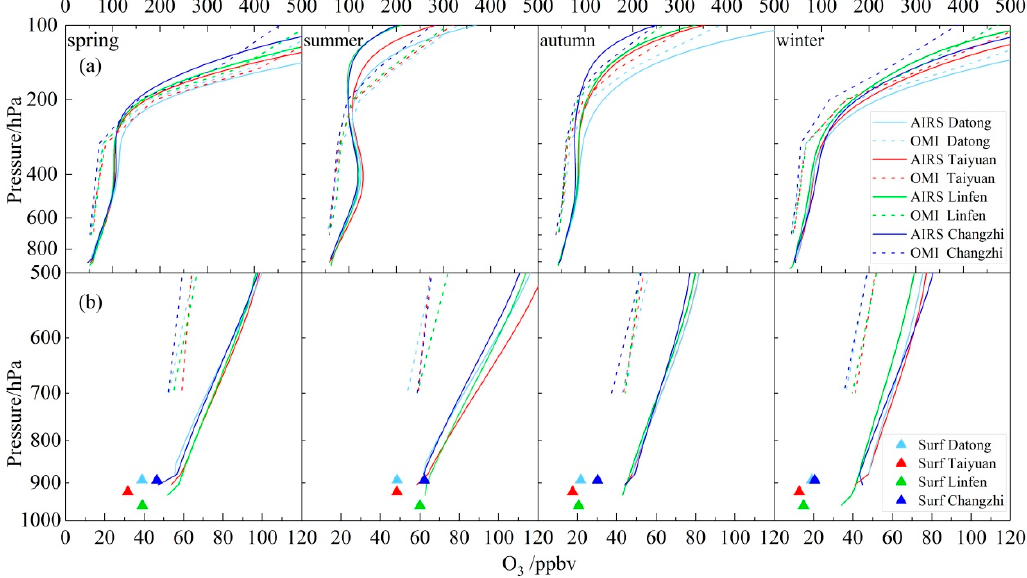
Figure 15. Seasonal mean O 3 volume mixing rate vertical profiles from AIRS (solid line), OMI (dotted line) and surface O 3 VMR (solid triangle) in Datong, Taiyuan, Linfen and Changzhi. ( a ):below 100 hPa;( b ): below 500 hPa.